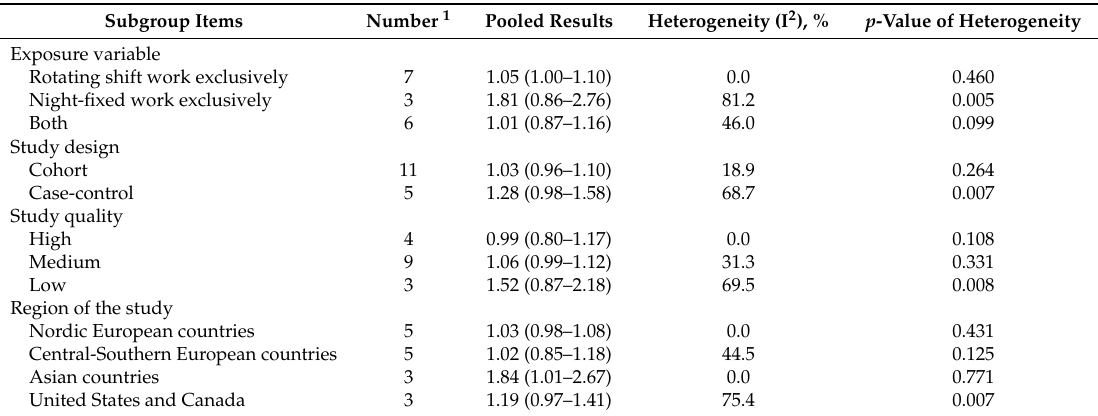
Table 2. Subgroup analyses of the relationship between shift work and prostate